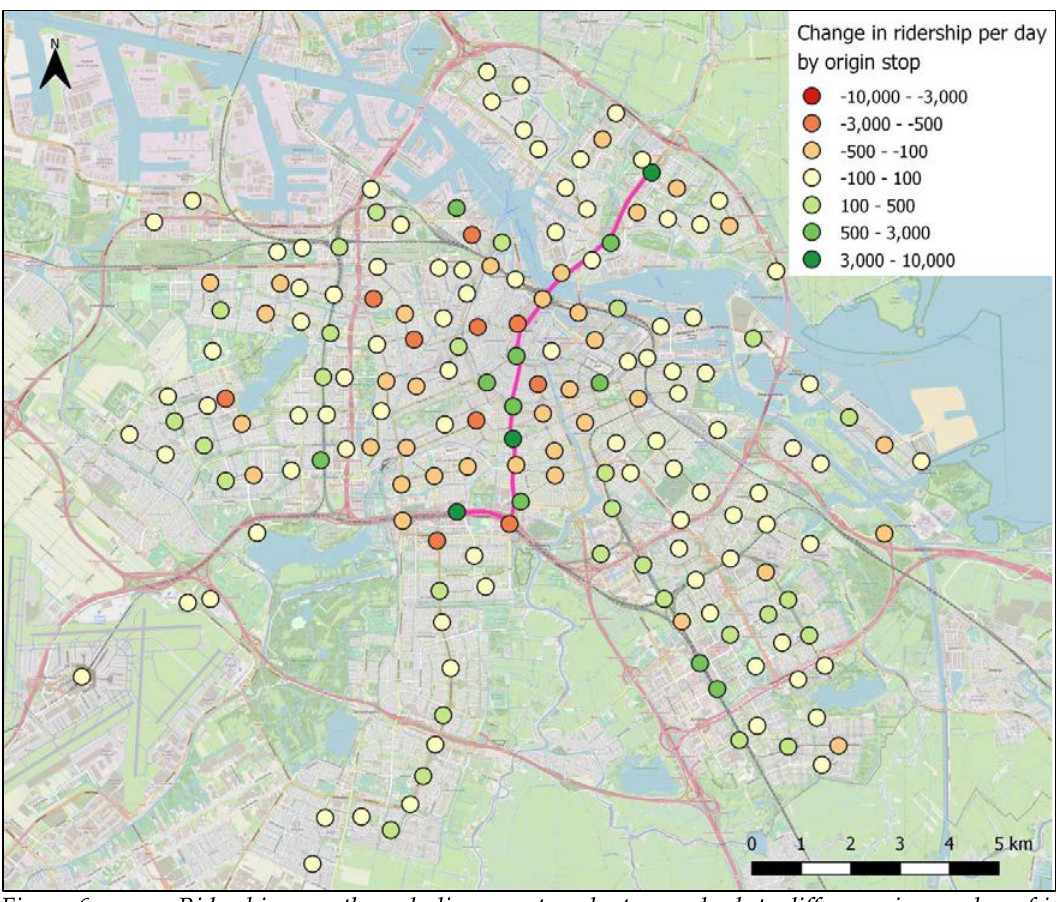
Figure 6. Ridership growth or decline per stop cluster as absolute difference in number of journeys (weekday 7am to 7pm) (Base map and data from OpenStreetMap and OpenStreetMap